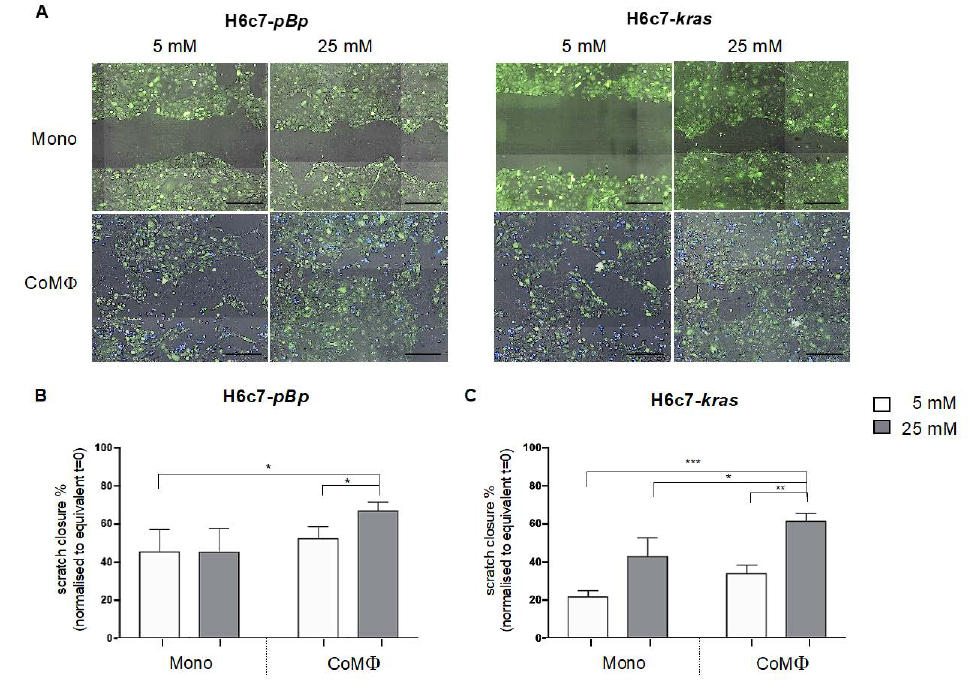
Figure 6. Exposure to macrophages and hyperglycemia promotes the migratory capacity of PDEC. H6c7- pBp and H6c7- kras cells were stained with CFSE and either mono- or cocultured with CellTrace TM Violet stained M1-polarized macrophages (M Φ ) for 2 days in normo- or hyperglycemic settings (5 or 25 mM of D -glucose). The migratory potential was evaluated via scratch assay using the NyONE Cell Imager. Scratch closure was assessed at t = 0 h and t = 16 h for H6c7- pBp cells ( A and B ) and at t = 0 h and t = 8 h for H6c7- kras cells ( A and C ). In ( A ), representative images are shown at t = 16h for H6c7- pBp cells and at t = 8 h for H6c7- kras cells taken with the NyONE imager. The scale bar=1000 µ m. In ( B and C ), data are expressed as % scratch closure normalized to t = 0 h. Normally distributed data are presented as mean and standard error of mean; * p < 0.05; ** = p < 0.01; *** = p < 0.001; n =